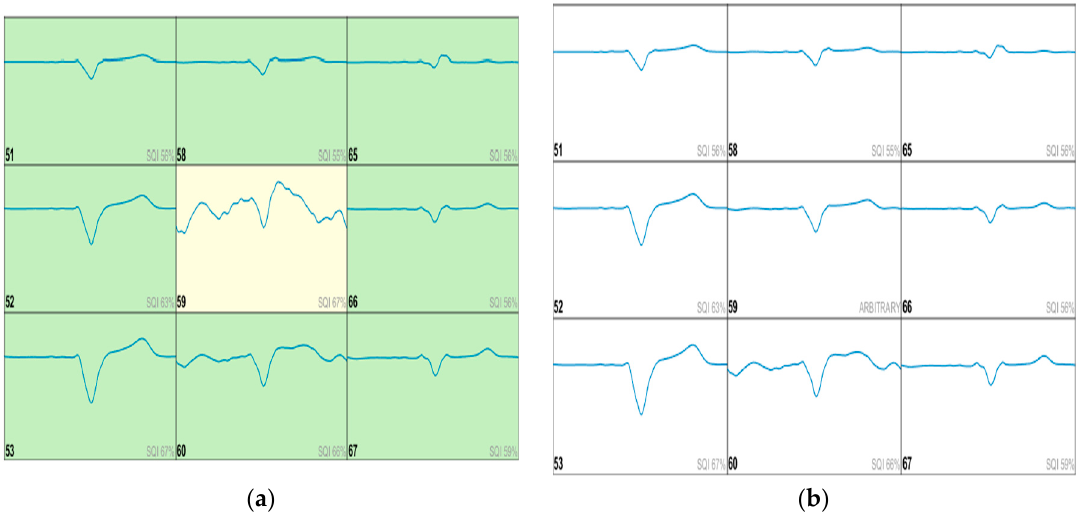
Figure 5. ( a ) Example of the signal (in the middle) before its replacement by calculation from signals in the neighborhood, ( b ) signal (in the middle) after calculation.